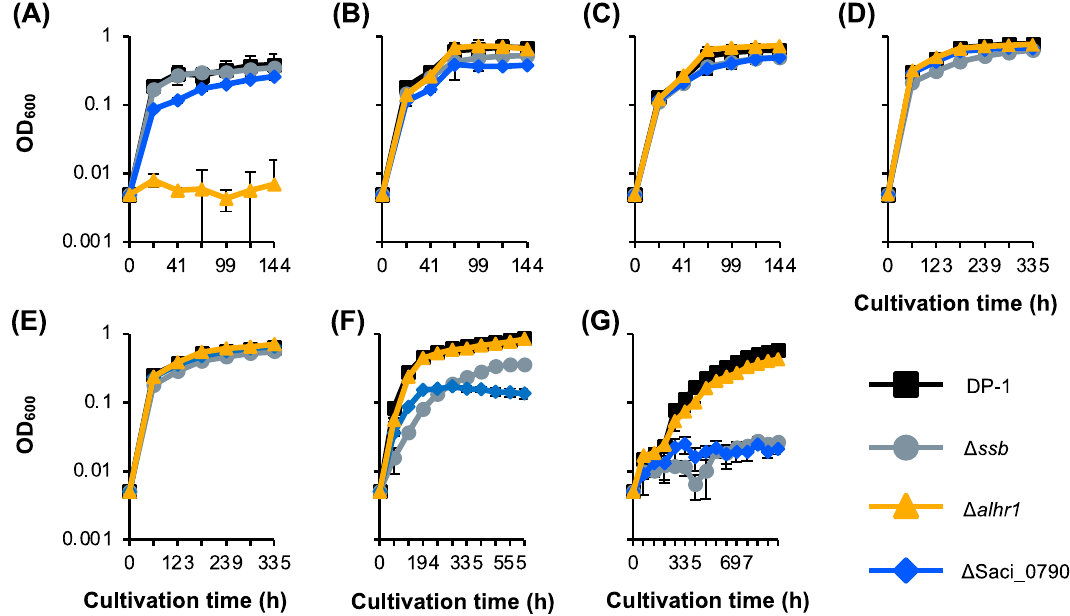
Figure 7. Growth curve of gene-deletion strains at various temperatures. Cell density as a function cultivation time is shown for various temperatures ( A – G ): ( A ) 80 ◦ C. ( B ) 75 ◦ C. ( C ) 70 ◦ C. ( D ) 65 ◦ C. of cultivation time is shown for various temperatures ( A – G ): ( A ) 80 °C. ( B ) 75 °C. ( C ) 70 °C. ( D ) 65 °C. ( E ) 60 °C. ( F ) 55 °C. ( G ) 50 °C. Error bars represent ±SD calculated using three biological repli- ( E ) 60 ◦ C. ( F ) 55 ◦ C. ( G ) 50 ◦ C. Error bars represent ± SD calculated using three biological replicates. cates. The data for DP-1 and Δ ssb are the same as those of [38]. The data for DP-1 and ∆ ssb are the same as those of